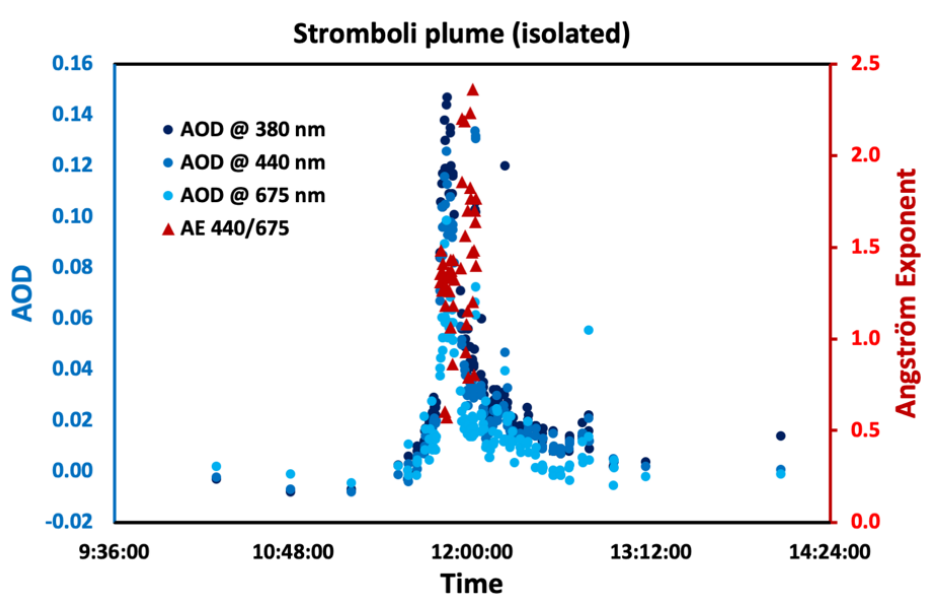
Figure 3. Atmospheric background corrected plume-isolated AOD P for Stromboli plume at 380 (dark blue dots), 440 (blue dots) and 675 nm (sky blue dots), and plume’s AE (red triangles). Time is UTC. Table 1. Average AE and AOD P at 440 nm for the two identified plume’s Sections 1 and 2 (see text for details). The averages are displayed with their standard deviation, and maximum/minimum values interval. As a comparison, also the whole plume and atmospheric background values are reported.